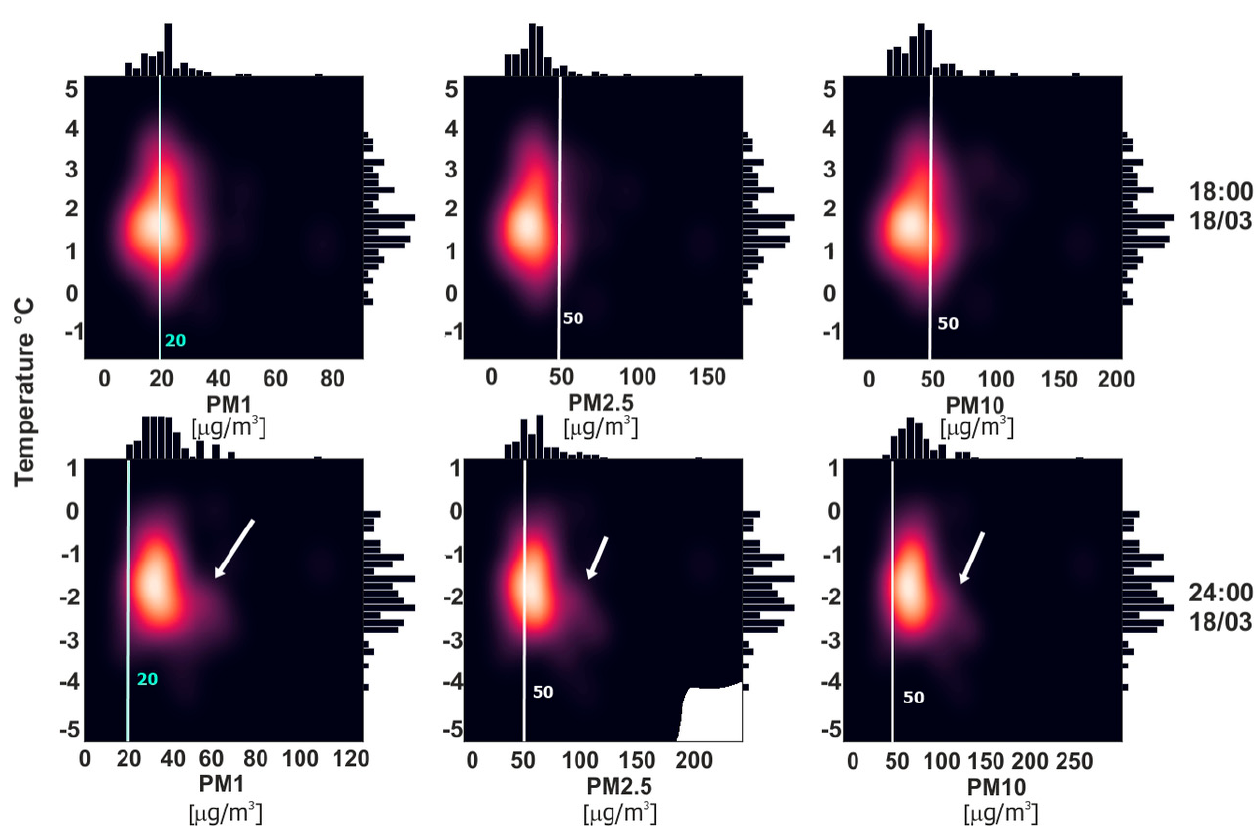
Figure 5. Kernel density estimate plots of PM1, PM2.5, PM10 and temperature at 18:00 and 24:00 on the 18th of March. Arrows indicate the increase in PM related to temperature and also to PT and PMV.